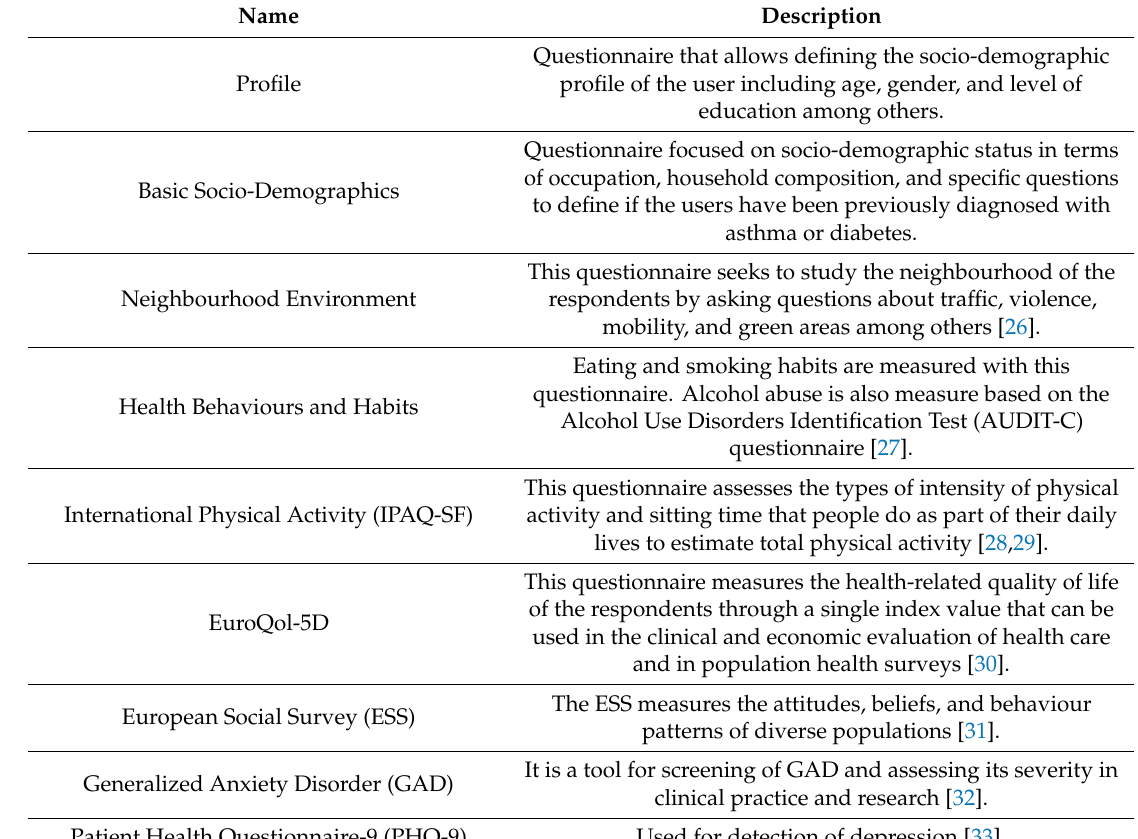
Table 1. List of